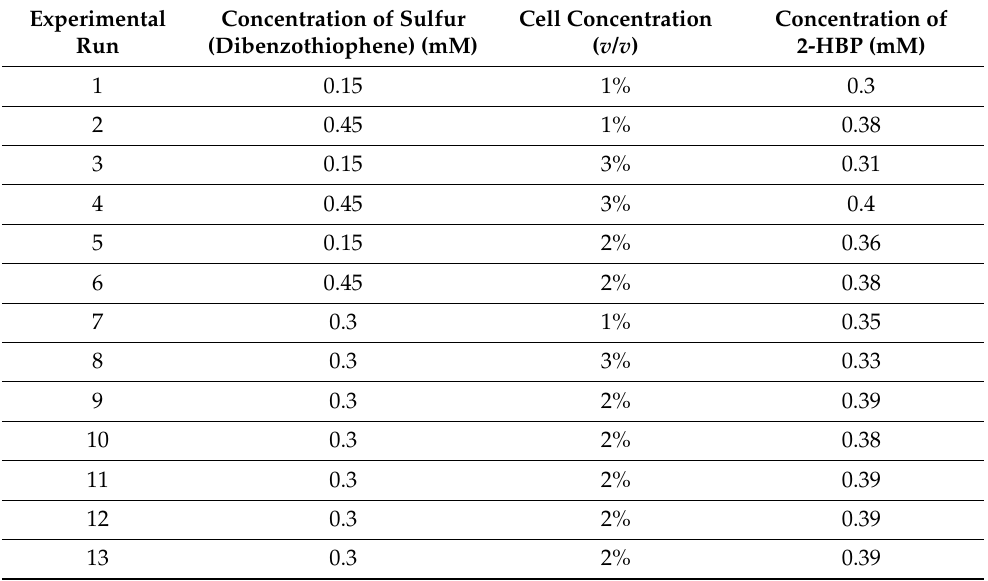
Table 1. The results of CCD for two factors (concentration of sulfur and cell concentration) and the production of 2-HBP by R. sp. strain IGTS8.